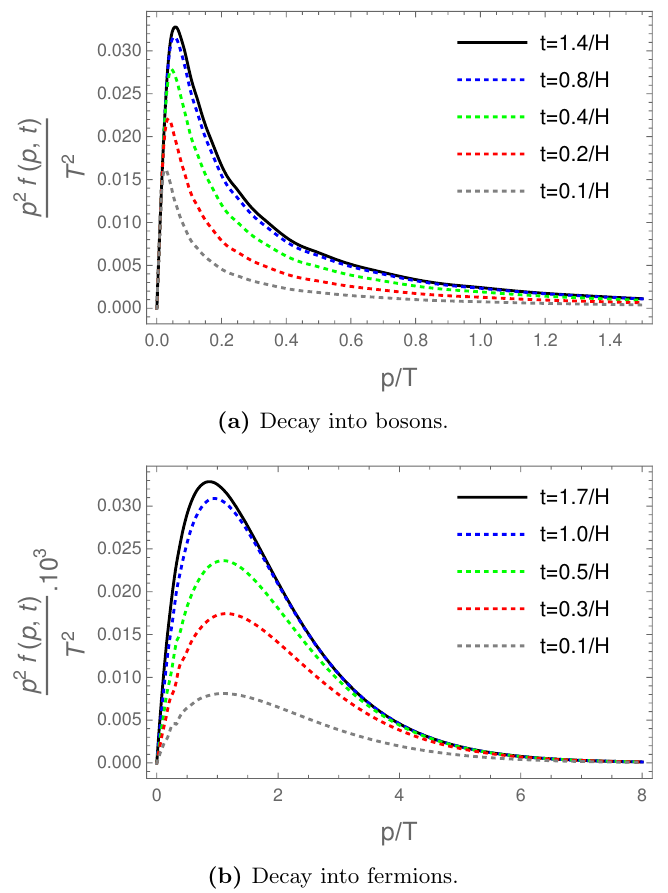
Figure 1. The phase space distribution at di(cid:11)erent times (in units of the Hubble parameter), as a function of the momentum p , for decay into bosons (a) and for decay into fermions (b). The parameters used are m X = 0 : 001 T , and (cid:0) ( B;F ) =H = 0 : 5, which corresponds to (cid:13) ( B ) 0 (bosons) and (cid:13) ( F ) = 10 (cid:0) 4 X